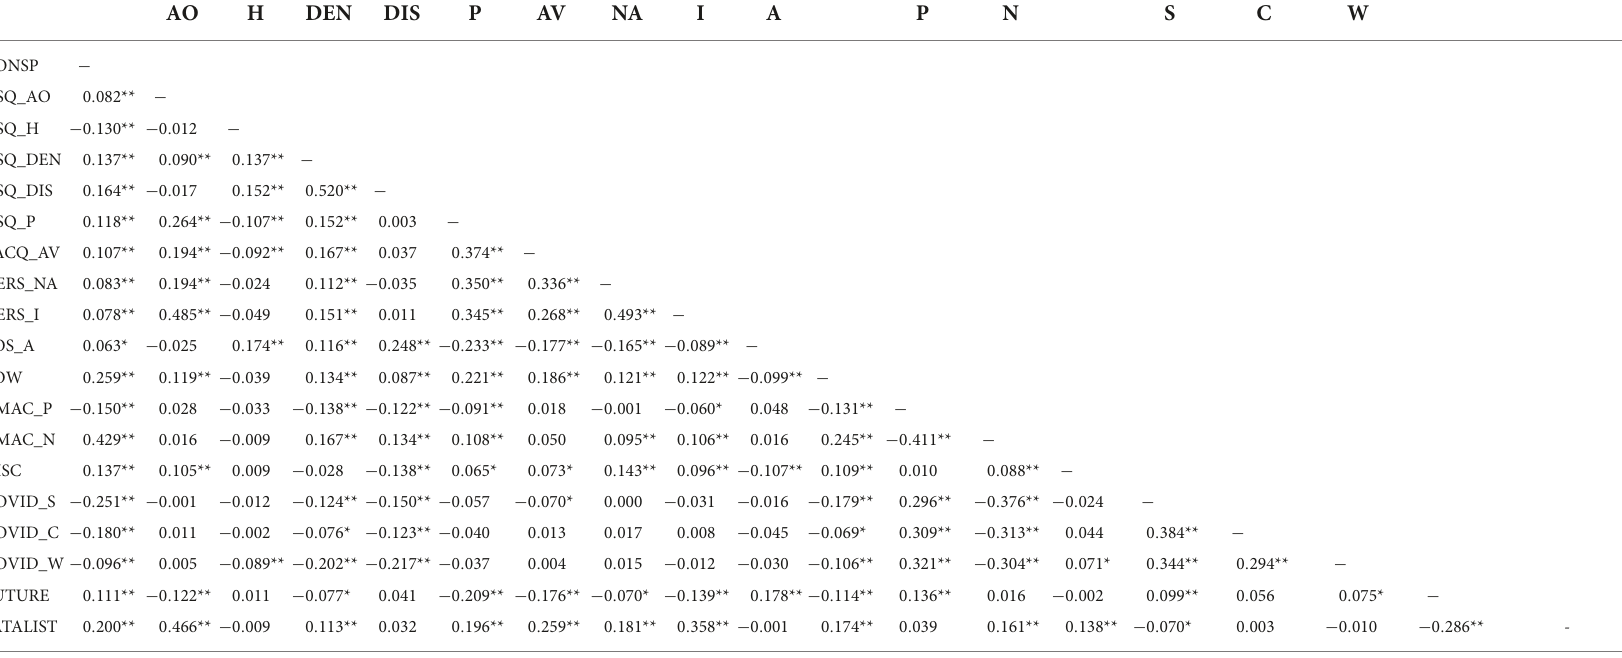
TABLE 2 Correlation analysis among the COVID-19 conspiracy scale and the examined